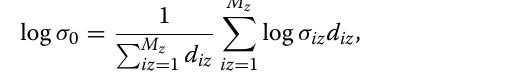
Fig. 9 NS cross sections at the easting of 200 m of the models inverted from all elements of the distorted MT impedance tensor (ZLOGA) using different initial